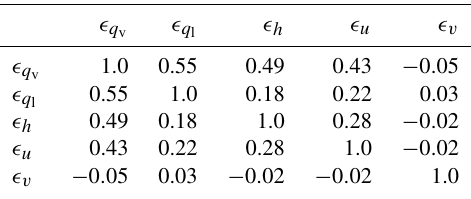
Table 1. Correlation matrix at model level 27 of the transport flux errors of water vapour ( q v ), cloud water ( q l ), enthalpy ( h ), and zonal ( u ) and meridional ( v )